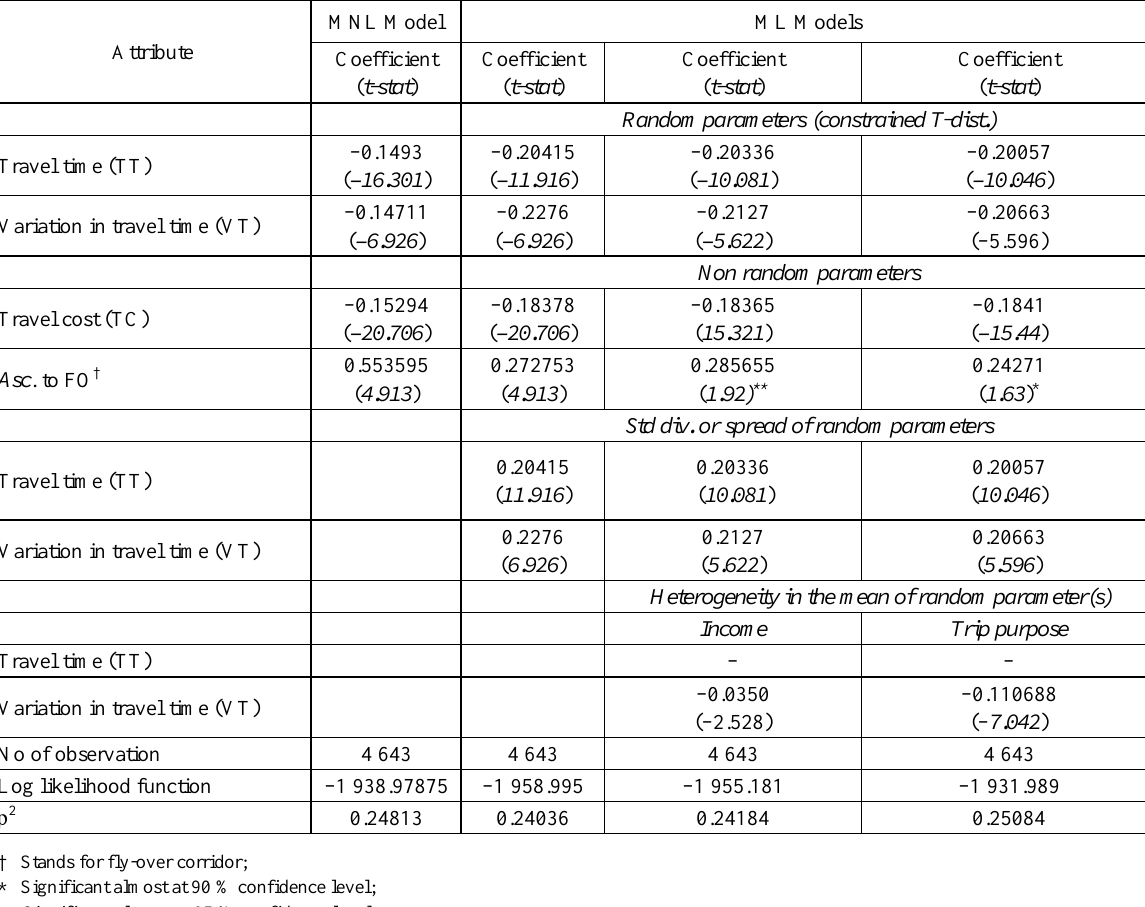
Table 4. Coefficients estimate from MNL and ML techniques for private car trip